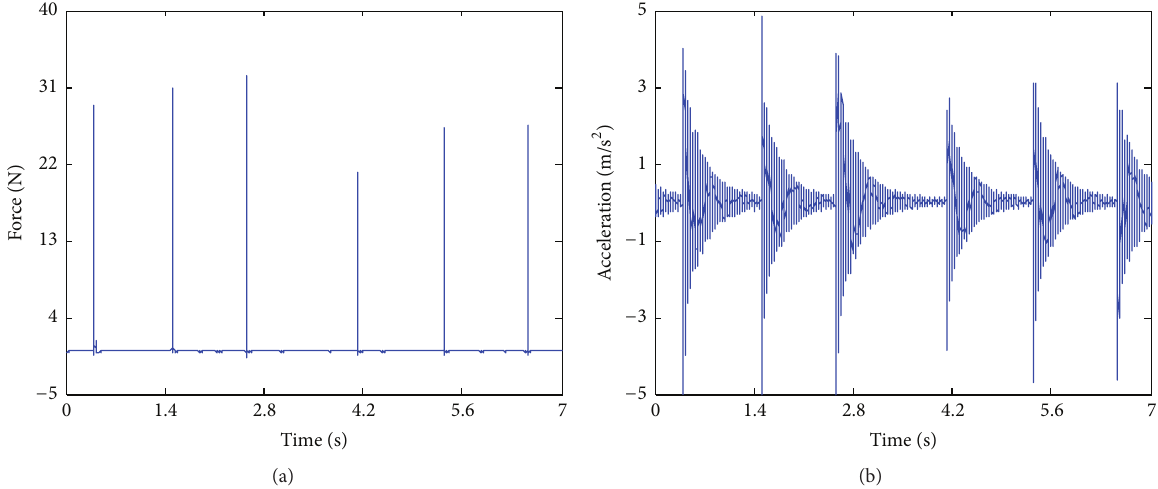
Figure 21: The measurement data from force transducer and accelerometer: (a) impact loads and (b) acceleration responses.